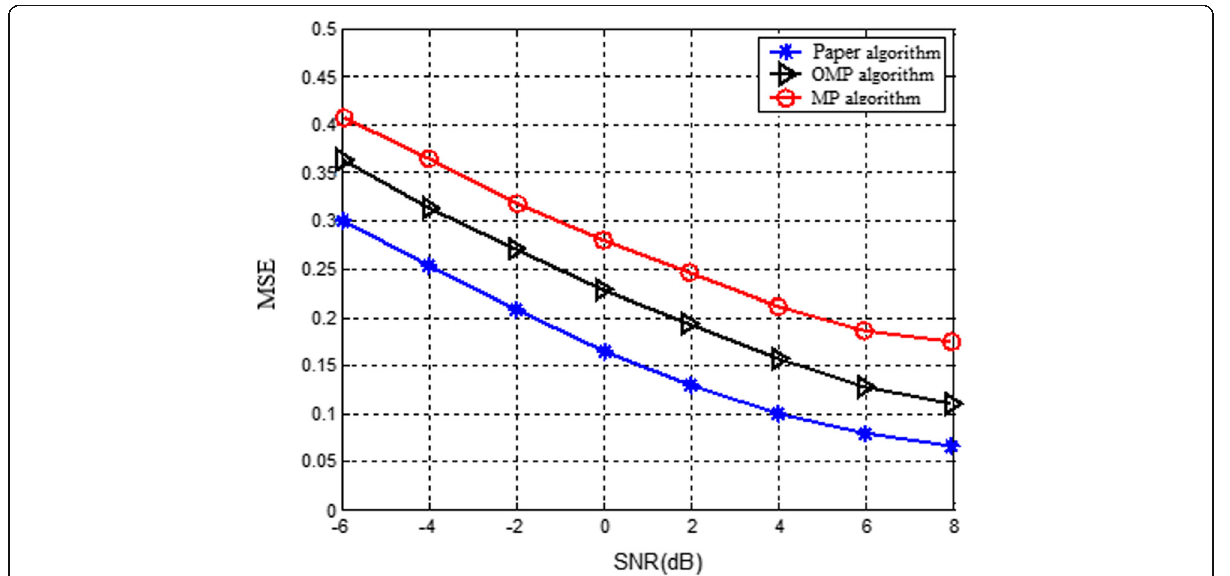
Fig. 2 Normalized error performance of different algorithms under white Gaussian noise. In the wideband spectrum signal detection, there are various kinds of interference in the channel, and the performance of the algorithm is also affected by the noise. However, from the derivation of the wideband spectrum cooperative perception algorithm based on compressed sensing, we find that the parameters of the updating iterative process have nothing to do with noise variance, so this part of the perception algorithm can effectively reduce the impact of noise, eliminate the uncertainty of noise variance SNR, and improve the accuracy of the detection algorithm. At different noise levels, the performance of the algorithm is verified. In Gaussian white noise, Fig. 2 describes the normalized error performance of different algorithms. The comparison